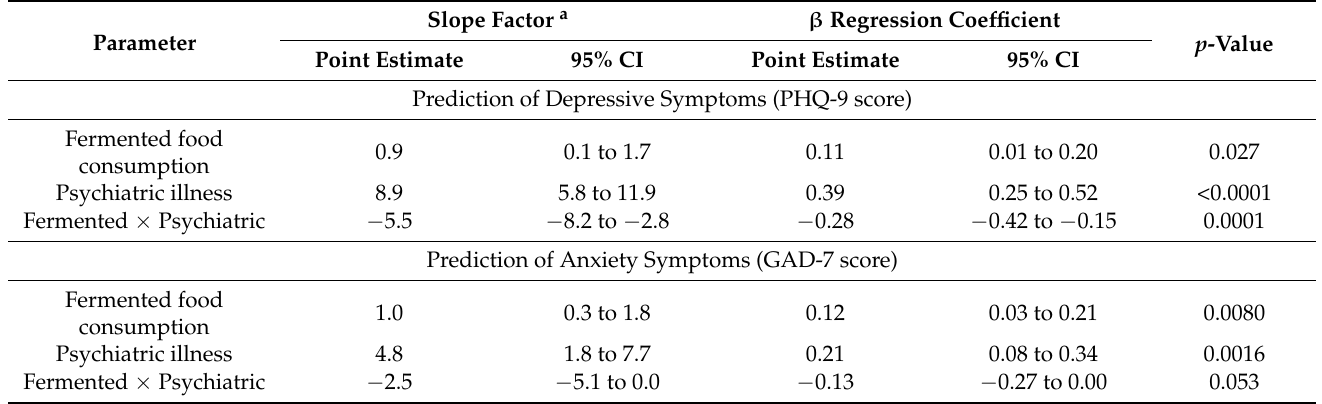
Table 2. Consumption of fermented food and psychiatric illness interaction models for predicting de- pressive and anxiety symptoms under psychological stress. The analyses included 25 psychiatrically ill and 372 healthy medical students. The presented analyses were adjusted for potential confounders: sex, BMI, physical activity, overall diet quality (pre-exam Starting the Conversation scale), and four out of five personality traits (Big Five Inventory-Short): neuroticism, extraversion, agreeableness, and